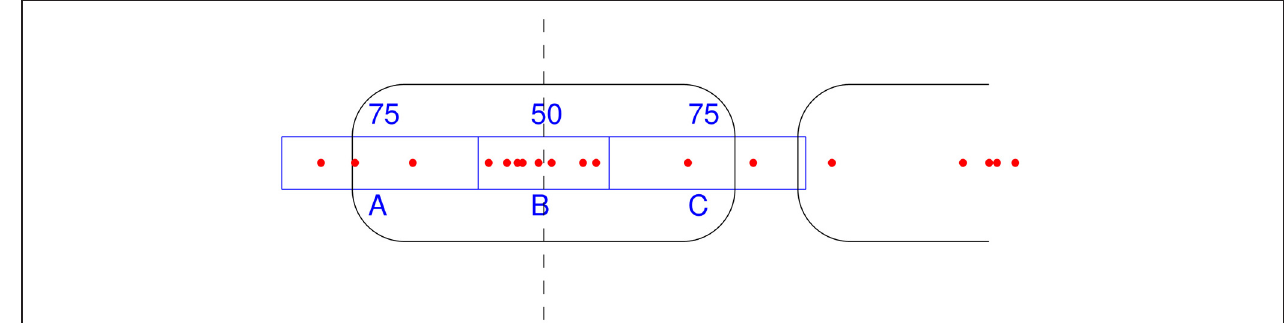
FIGURE 6 | How the triangle statistic works. Red dots denote the centers of discretized beta distributions corresponding to reads, and rounded rectangles denote nucleosomes. The triangle statistic divides a scan-window into regions A, B, and C of sizes (in bp) 75, 50,